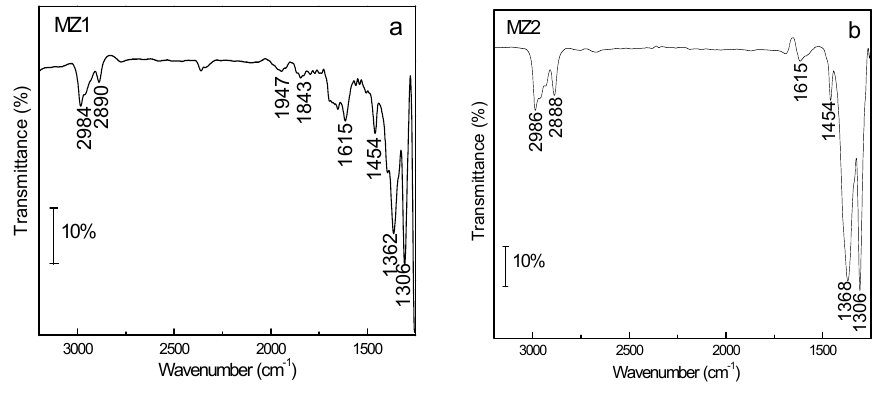
Figure 5. In-situ IR result of NPYR adsorbed on ( a ) MZ1 and ( b ) MZ2